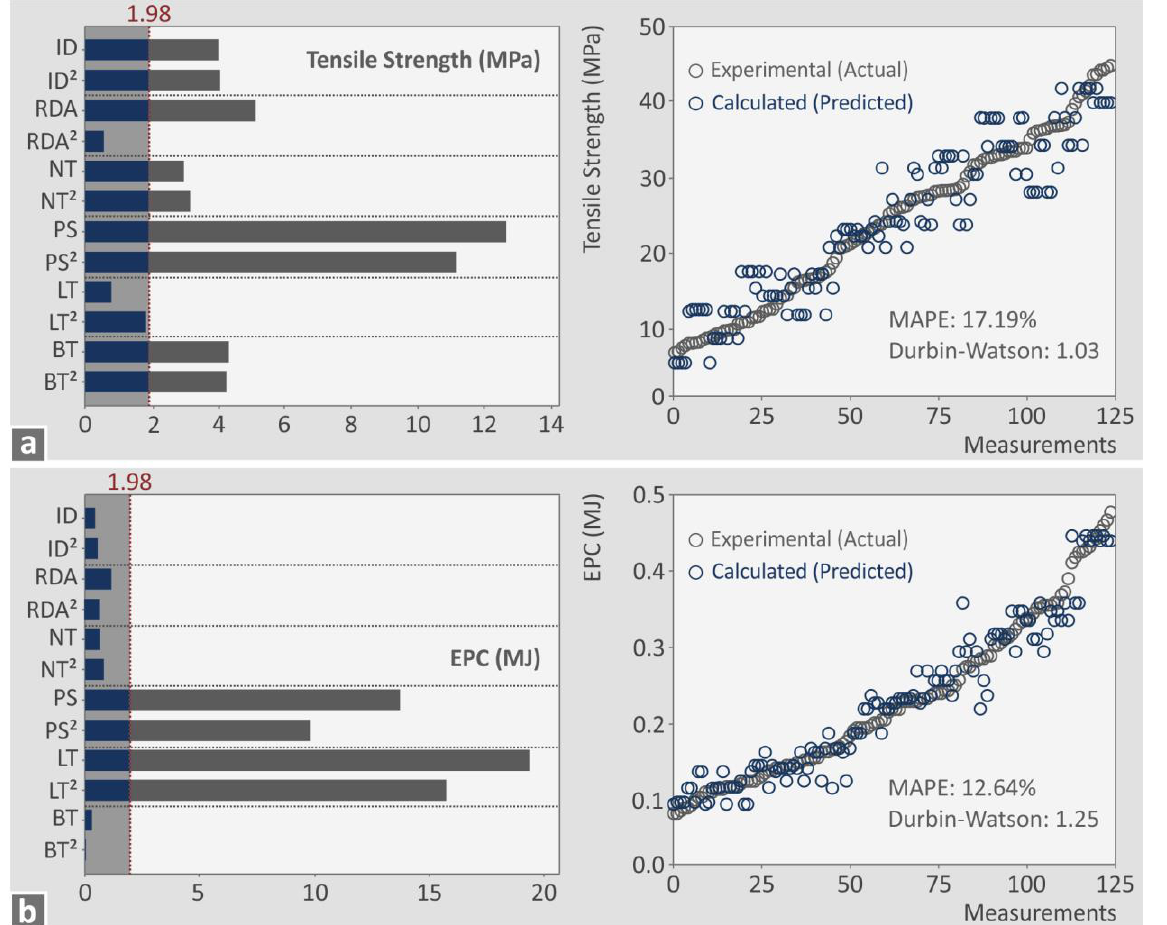
Figure 12. Pareto and experimental vs. calculated charts: ( a ) tensile strength (MPa), and ( b ) EPC (MJ).